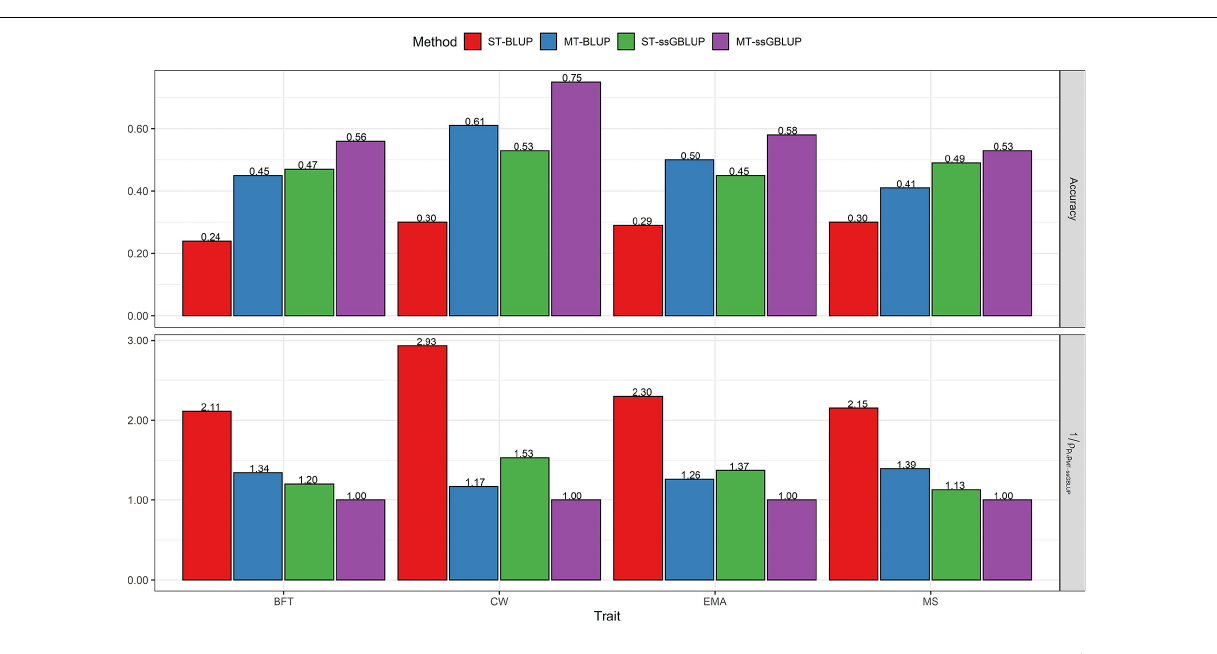
FIGURE 2 | Accuracy of breeding values obtained using BLUP (ST-BLUP, MT-BLUP) and ssGBLUP (ST-ssGBLUP, MT-ssGBLUP) models. 1 ρ increase of accuracy from i th model to MT-ssGBLUP in the partial data for steers at yearling date. ST and MT are single-trait and multi-trait analyses, respectively. BFT, backfat thickness; CW, carcass weight; EMA, eye muscle area; MS, marbling score; YW, yearling